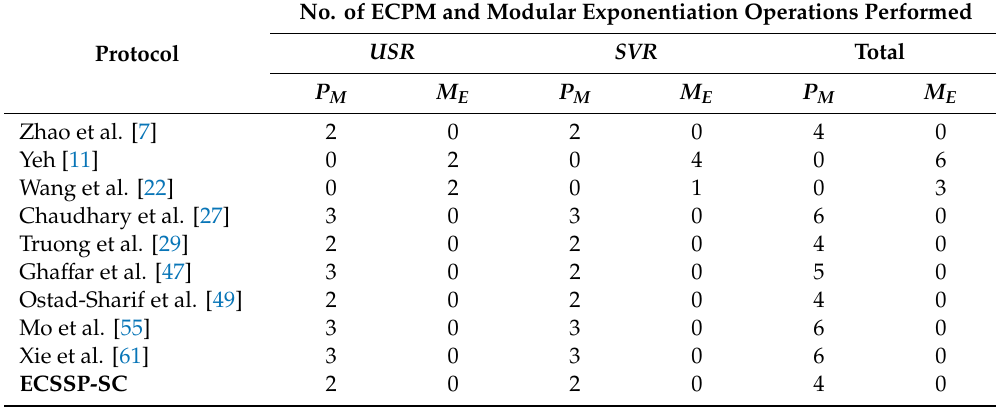
Table 4. Number of operations in di ff erent smart card security